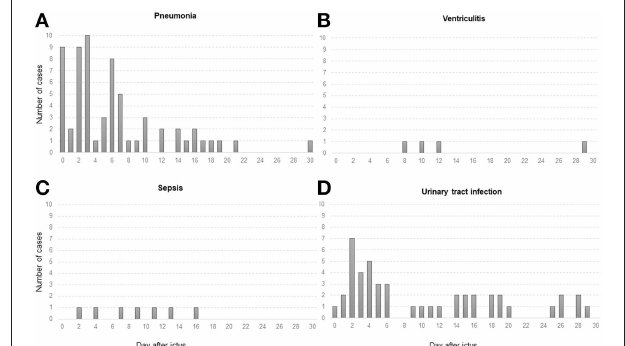
FIGURE 2 | Graphs display absolute numbers of cases with infectious complications (y-axis) based on days after admission (x-axis) for (A)